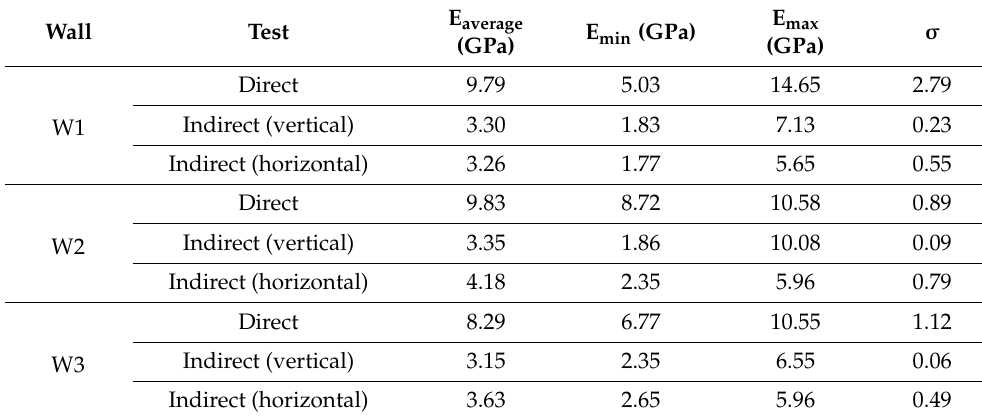
Table 2. Elasticity modulus values obtained from the sonic tests.